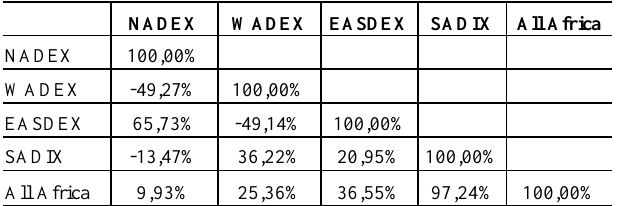
Table 9: Correlation analysis: Four African regional indices and the All-Africa Index